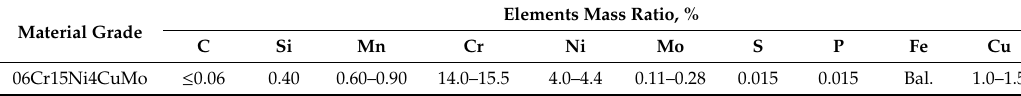
Figure 1. Surface of powder particles 06Cr15Ni4CuMo. Table 1. The chemical composition of the steel.